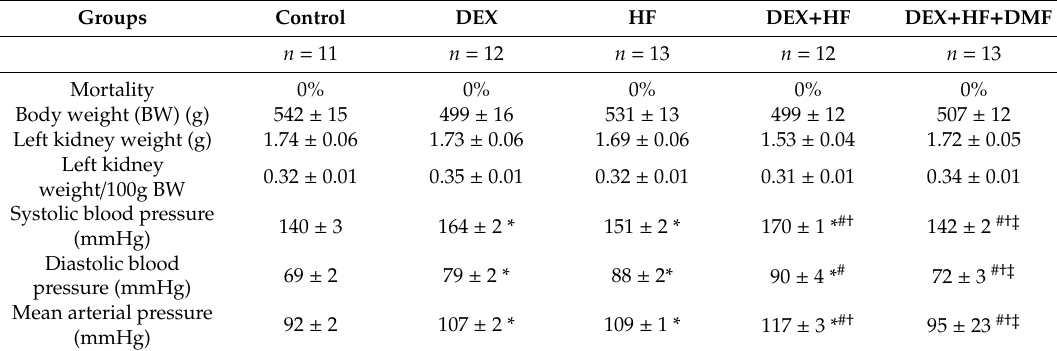
Table 1. Morphological and biochemical values in di ff erent experimental groups.